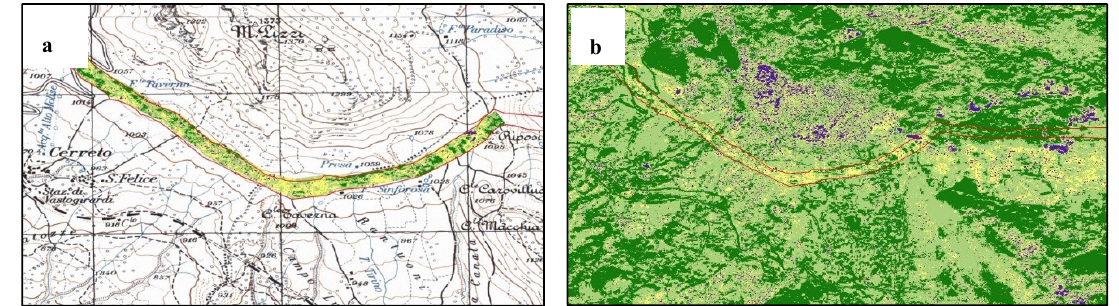
Figure 11. The result of the NDVI analysis in the pilot area (Tratturo Celano-Foggia): ( a ) selected stretch; ( b ) extended zone.